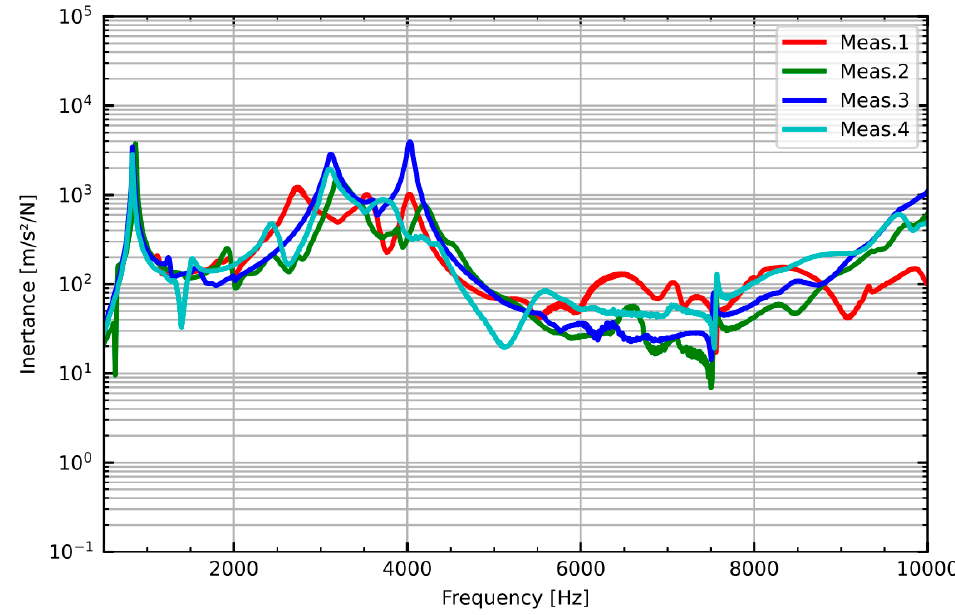
Figure 4. Repeatability of the “immersion filling”; repeated four times with the usage of water. The comparison between the two methods shows similar deviations for frequencies above 4000 Hz. “Immersion filling” also shows deviations in the frequency range below 4000 Hz. For “pouring filling”, deviations below the frequency of 4000 Hz are smaller in comparison to “immersion Filling”. Additionally, the handling of the fixture with “pour- ing filling” is easier than in comparison with the “immersion filling”. Because of the smaller deviations below 4000 Hz and the easier handling of the fixture, the “pouring method” is chosen as the suitable method to be used for future measurements. Figure 5 illustrates the five repetitions of the FRF measurement for transmission fluid as a medium. Over the entire frequency spectrum considered, the repeatability for the gear oil proves to be considerably better compared to the water medium, in Figure 3 and Figure 4. Over the complete range of the frequency spectrum, the deviation between the meas- urements of the transmission fluid is visibly smaller than in water media. The overall level of the amplitude of the FRFs is identical to the levels in water media. The course of the FRFs of transmission fluid is identical to the FRFs of water media. Due to the smaller de- viation of the FRFs of the transmission fluid, more resonances are identifiable and de- tailed, for example, at 2300, 9000, and 9500 Hz. This improved deviation can be due to the increased viscosity of transmission fluid over the viscosity of water. An increased devia- tion is observed around 3800 and 6250 Hz. This could be due to structural resonances or other side effects in the excitation of the structure.